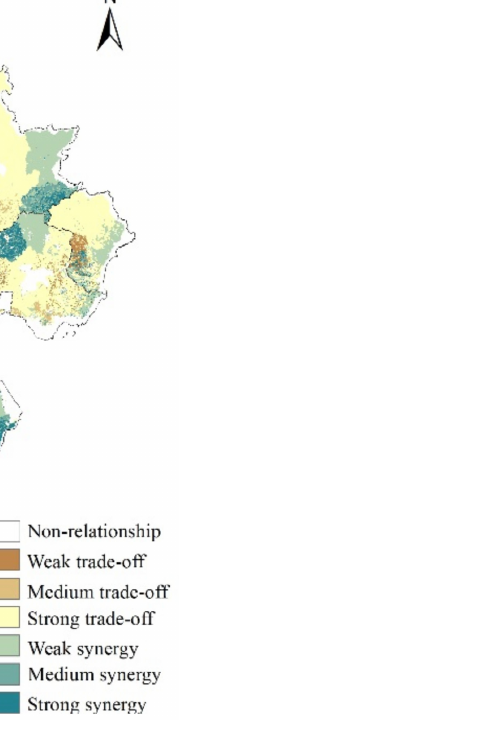
Figure 9. The distribution of trade-offs/synergies between ESs and HWB in Hebei during 2000–2015. Table 8. The proportion of trade-off/synergy area between ESs and HWB in Hebei during